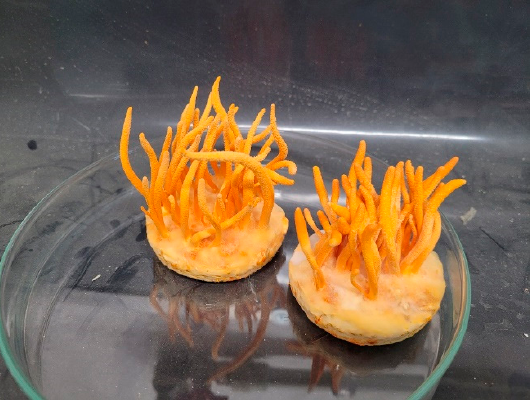
Figure 1. Self-cultivated Cordyceps militaris (photo by Piotr Zi ę ba).